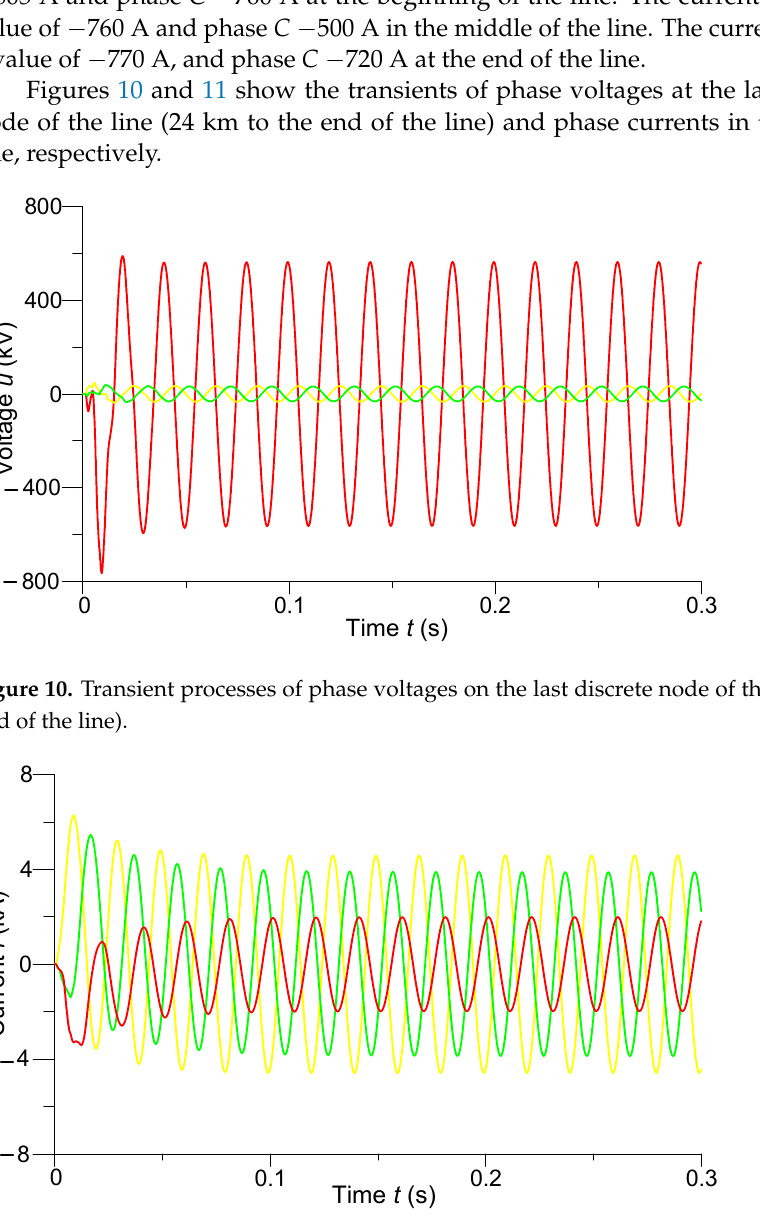
Figure 11. Transient processes of phase currents in the middle of the line.